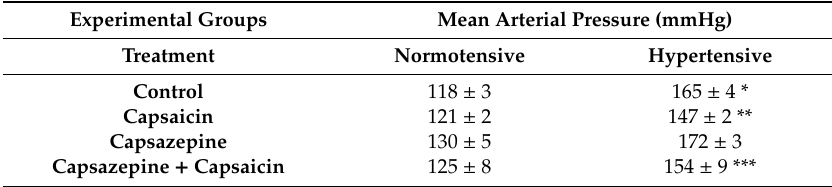
Table 1. E ff ect of capsaicin and capsazepine in mean arterial pressure on normotensive and hypertensive rats.